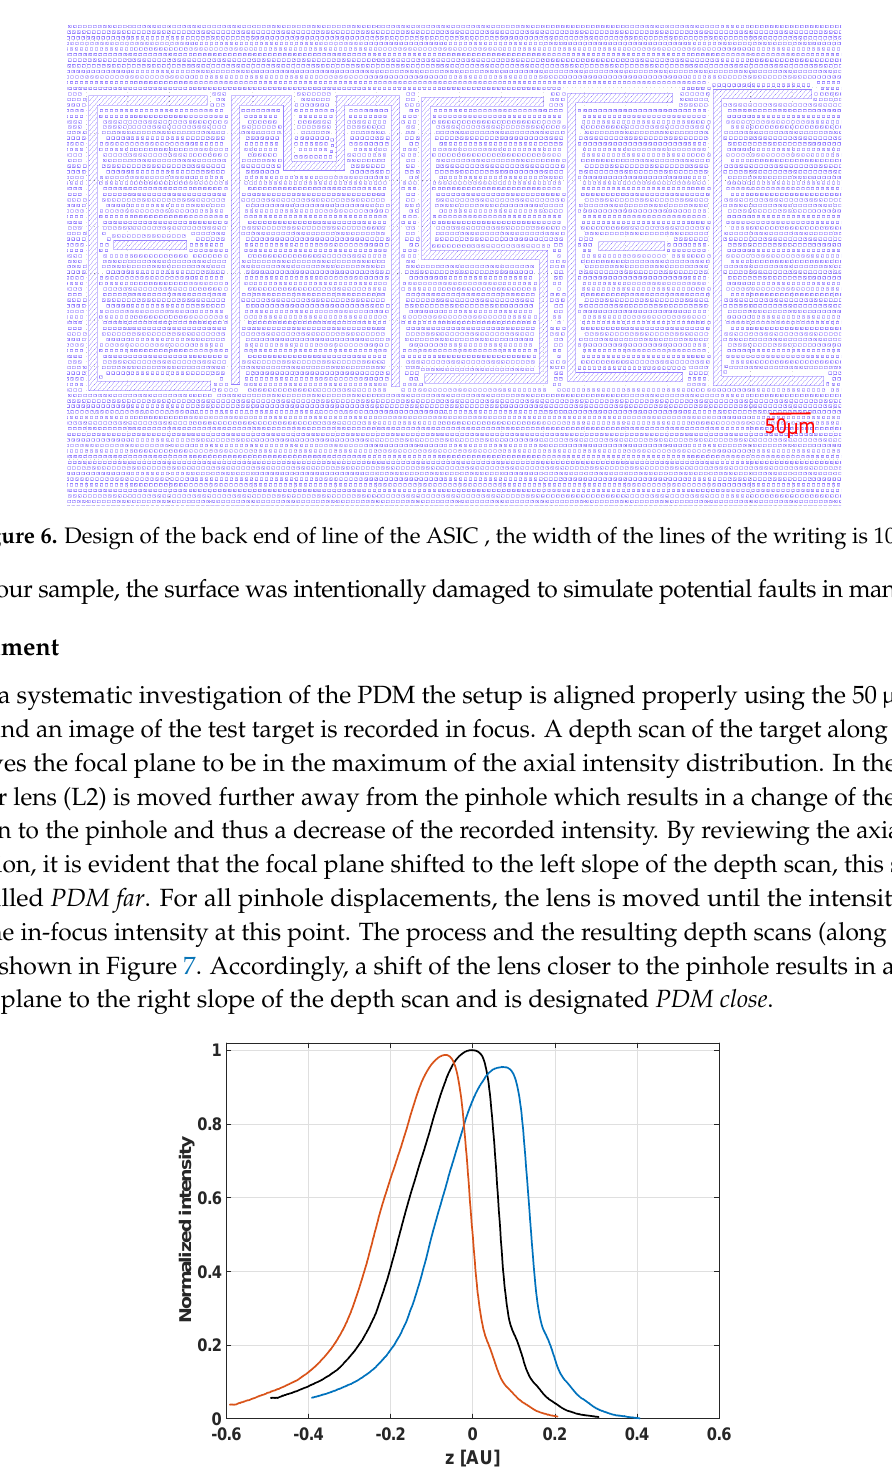
Figure 7. Z-scan of the sample with maximum intensity in focal plane (black curve), PDM far (blue) and PDM close (red) using the 10 AU